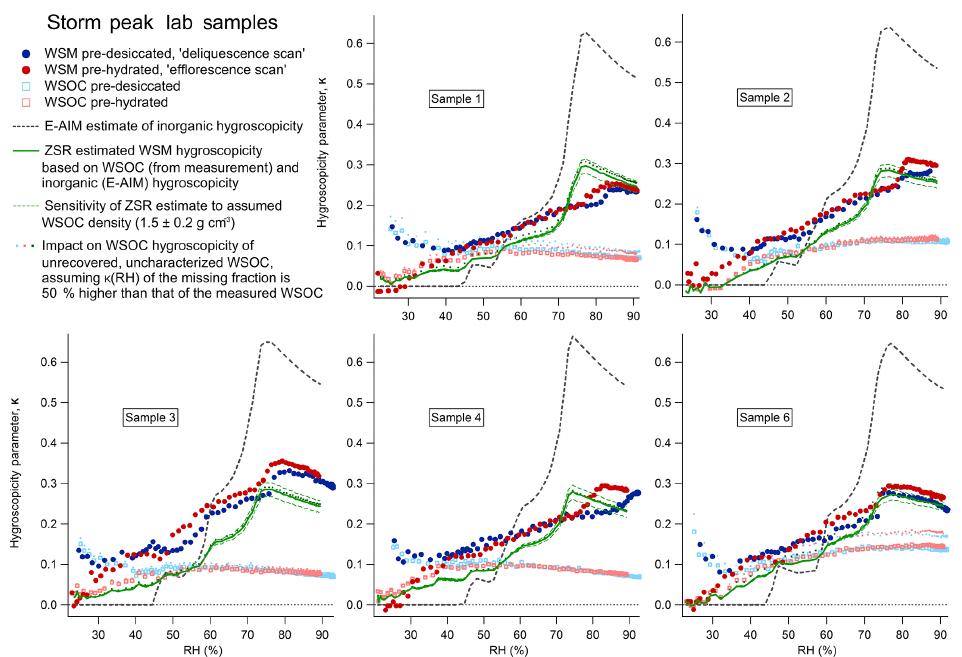
Figure 4. Comparison of the measured hygroscopicity of SPL WSM samples to expected WSM hygroscopicity assuming no interaction between the organic and inorganic components. WSM hygroscopicity (in green) was estimated from independent assessments of the hygro- scopicity of the organic fraction (from WSOC measurements) and of the inorganic fraction (predicted from composition using the E-AIM model). For each sample, WSM hygroscopicity is underestimated below 70% RH, driven by the expectation of the model that the majority of the inorganic fraction will not dissolve until RH reaches ∼ 70%. This suggests that WSOC can significantly depress inorganic DRH, enhancing water uptake below 70%